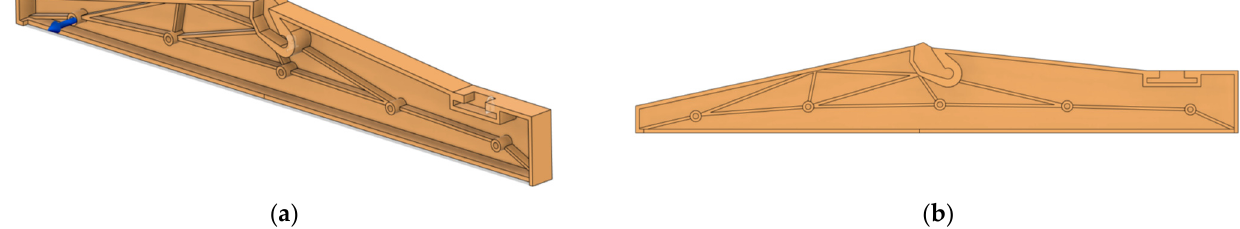
Figure 6. One half of the simplified class-divider model shows where the loads and boundary conditions are applied in Fusion 360 ( a ), and in-plane view of one half of the class-divider design ( b ).